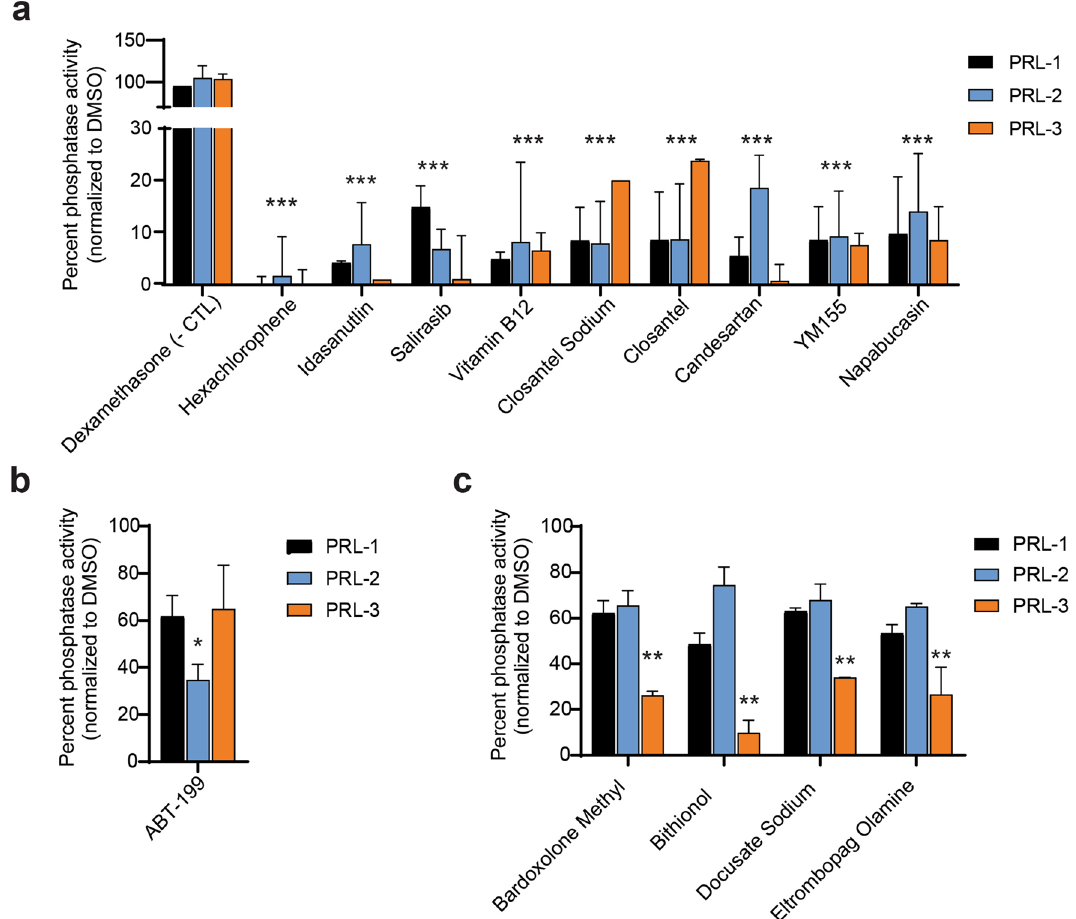
Figure 1. Multiple FDA-approved compounds inhibit the phosphatase activity of PRL proteins. ( a ) Validation of drugs that were positive hits in the initial FDA-drug screen and significantly reduced PRL phosphatase activity across multiple tests. The FDA-approved drug Dexamethasone, which has no effect on PRL-3 phosphatase activity, was used as a negative control (- CTL). ( b ) ABT-199 demonstrated selectivity in inhibiting PRL-2. ( c ) Validation of PRL-3 specific inhibitors. All assays were run at a final PRL protein concentration of 2.5 µM, a drug concentration of 40 µM, and DiFMUP concentration at the previously reported K M of the protein. Bars represent the average phosphatase activity of the initial screen plus two additional independent experiments, in triplicate. Error bars represent standard deviation. * p < 0.05, ** p < 0.001, *** p < 0.0001 by either two-way ANOVA with Dunnet’s correction ( a ) or one-way ANOVA with Tukey’s HSD ( b , c trol for PRL-3 inhibition, Thienopyridone, had no effect on the viability at drug doses ranging from 1 to 100 µM (Fig. 3a) after 16 hours of incubation with the compounds. Candesartan showed insignificant effect on viability up to the concentration of 50 µM but viability dropped significantly at 100 µM, indicating potential toxicity of the compound at concentrations well above the IC 50 for PRL-3 inhibition. Hexachlorophene and Closantel increased MTT absorbance in 293T cells (Fig. 3b). Finally, Idasanutlin, YM155, and Napabucasin decreased via- bility of 293T cells (Fig. 3c), most likely due to these drugs having a known higher affinity for proteins involved in apoptotic pathways 47,48 and potentially other off-target effects. As the ultimate goal of this study is to identify drugs that could be used as anti-cancer therapy in PRL-3 expressing tumors, we eliminated drugs that enhanced cell viability, and focused on those that decreased or caused no change in cell viability. FDA‑approved drugs blocked PRL‑3 induced cell migration in human cancer cells. PRL-3 is well-established to promote cell migration. Scratch assays were used to test whether broad PRL inhibitors would alter the migratory phenotype of PRL-3 overexpressing HEK293T cells and human colorectal cancer cells that have endogenously high levels of PRL-3. Transfection of a PRL-3 expression vector increased PRL-3 expres- sion in HEK293T cells by fourfold and enhanced cell migration by 40% ( p = 0.02, Fig. 4a, Supplemental Fig. 5). Empty vector and PRL-3 transfected cells were then treated with the broad PRL inhibitors at concentrations that were previously found to not affect cell viability by more than 25%. Treatment with two of the drugs, Sali- rasib and Candesartan, resulted in a significant inhibition of cellular migration in PRL-3 overexpressing cells, compared to DMSO treatment (Salirasib, p = 0.03 and Candesartan p = 0.001, Fig. 4b, c) with no corresponding reduction in migration in control cells. These data indicate that these drugs can directly inhibit PRL-3 to impact